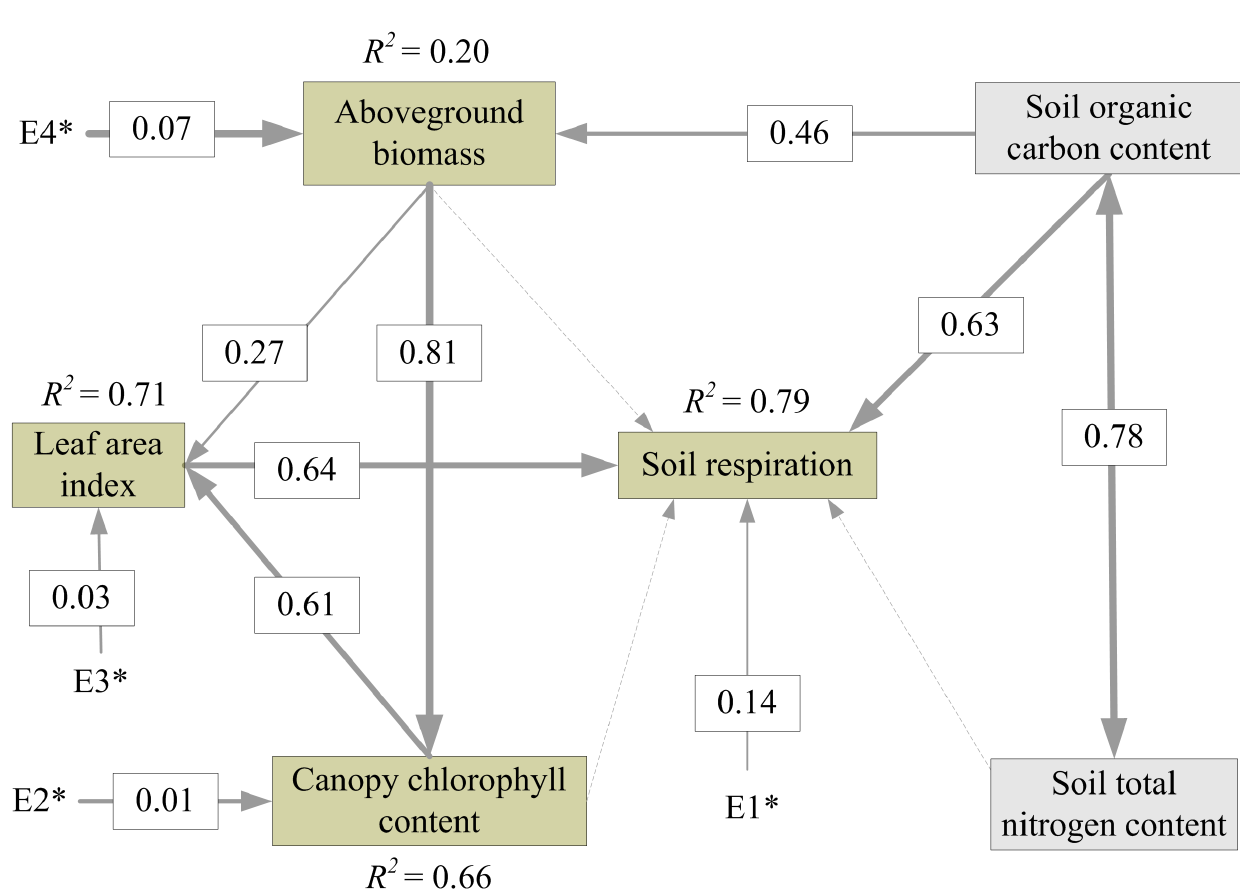
Figure 2. Final structural equation modeling (SEM) for soil respiration. Non-significant paths are shown in dashed line. The thickness of the solid arrows reflects the magnitude of the standardized SEM coefficients. Standardized coefficients are listed on each significant path. * represents error terms for observed variables, among them, E1, E2, E3, and E4 represent measurement errors for soil respiration, canopy chlorophyll content, leaf area index, and aboveground biomass,